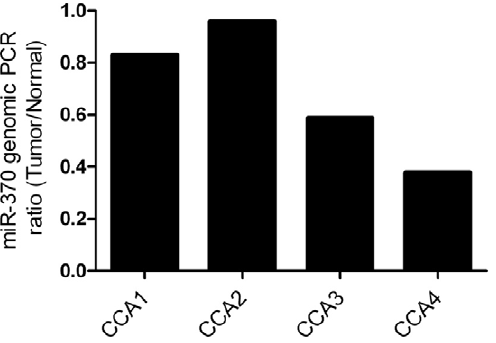
Figure 5. Two of the four CCA tissues displayed LOH at miR- 370 locus vs. matched normal tissues. For each CCA specimen, we calculated the ratio between the level of miR-370 DNA in cancer vs. matched normal specimen. This ratio is displayed on the Y-axis. A ratio close to 1 (as shown for CCA1 and CCA2) signifies no LOH while a ratio close to 0.5 (as in CCA3 and CCA4) suggests LOH at miR-370 in CCA vs. matched normal tissue.